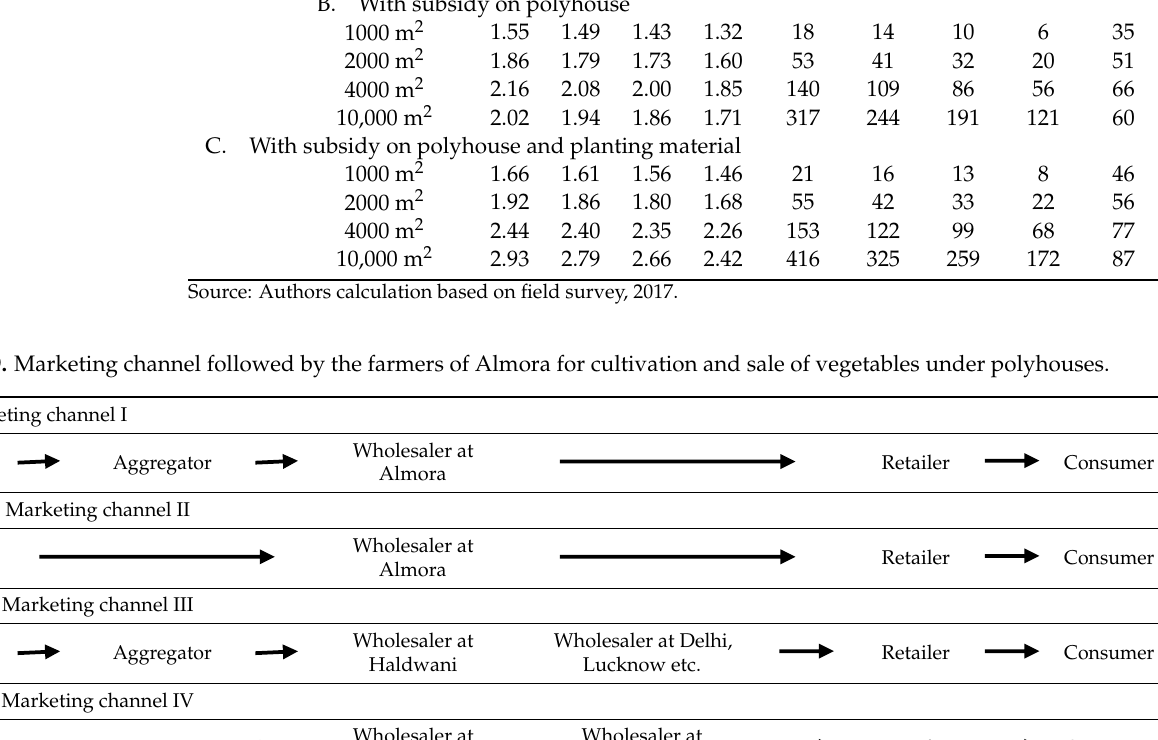
Table 18. Feasibility of polyhouse cultivation of Gerbera under climate change conditions. Sl. No.